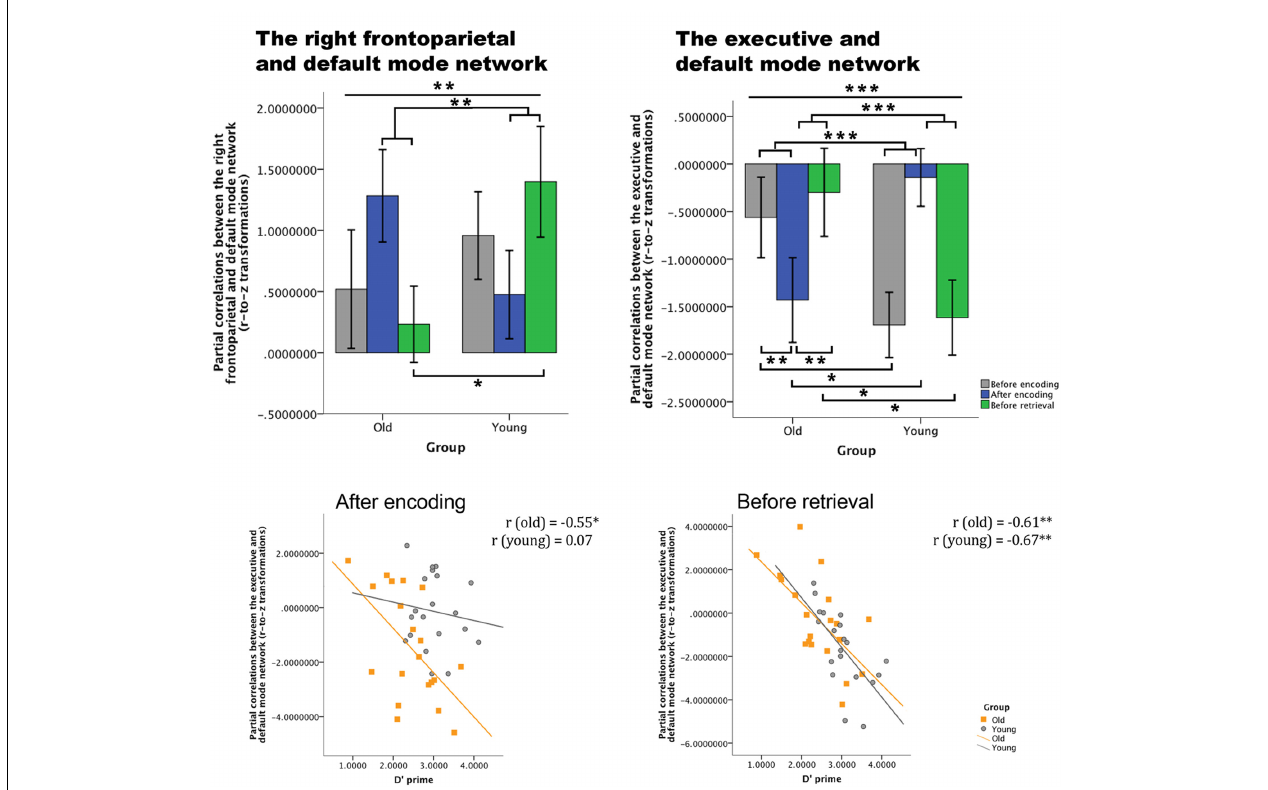
FIGURE 7 | Differences over time between young and old in across-network coupling and the association with memory performance. Top row: partial correlations ( r -to- z transformed) between networks over time for both groups (error bars indicate 1 standard error). Bottom row: correlations between on the one hand the partial